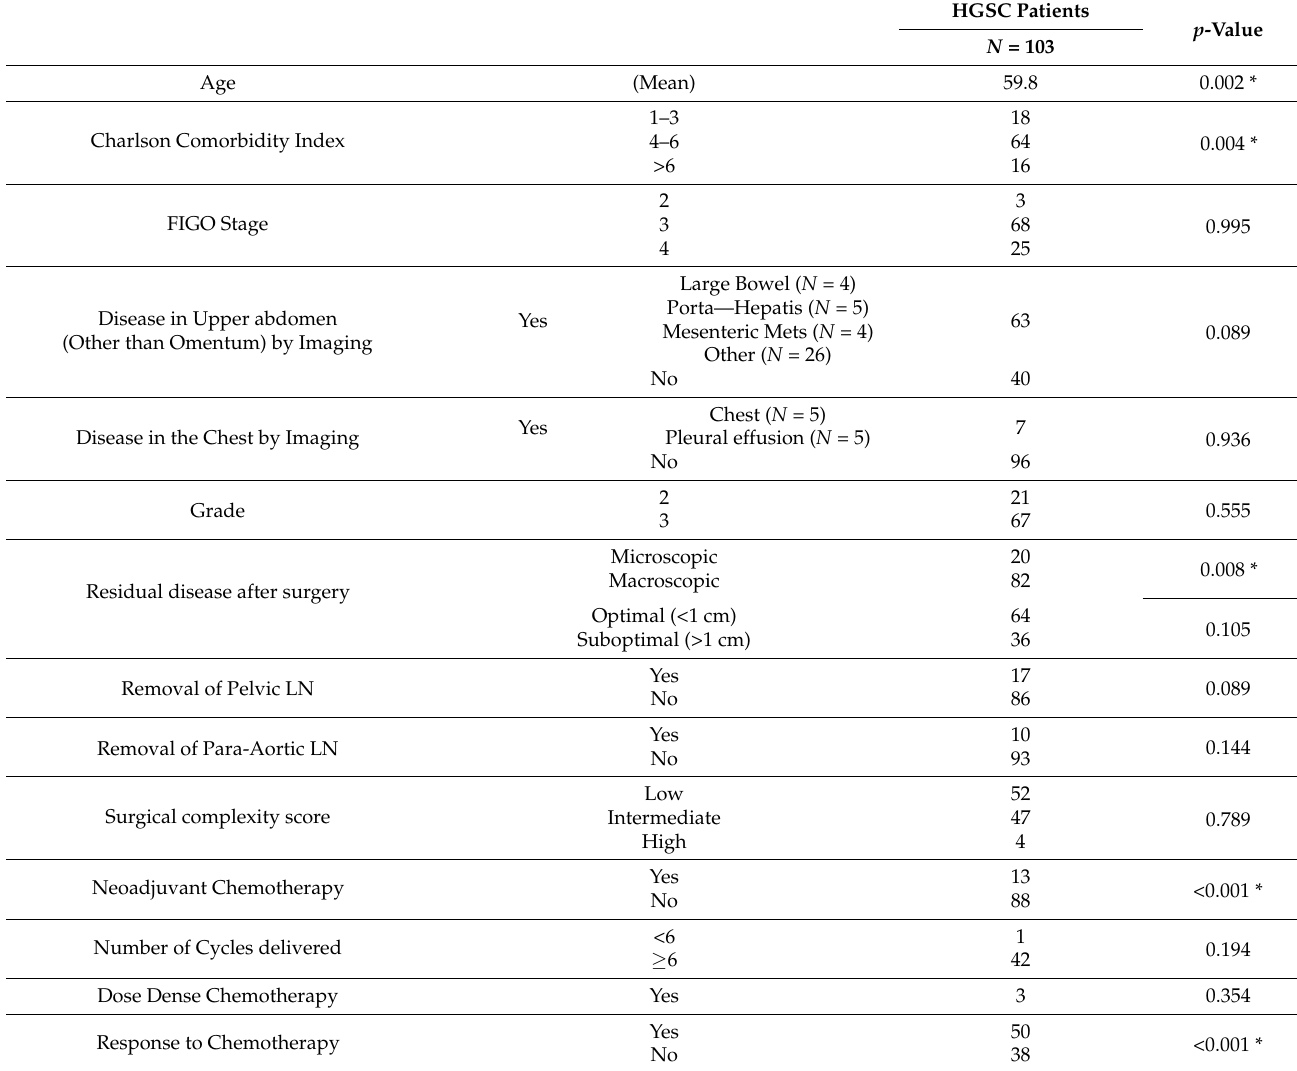
Table 1. Patient characteristics and association with survival: Out of the 122 patients with HGSC, 103 had complete clinical and outcomes information for the survival